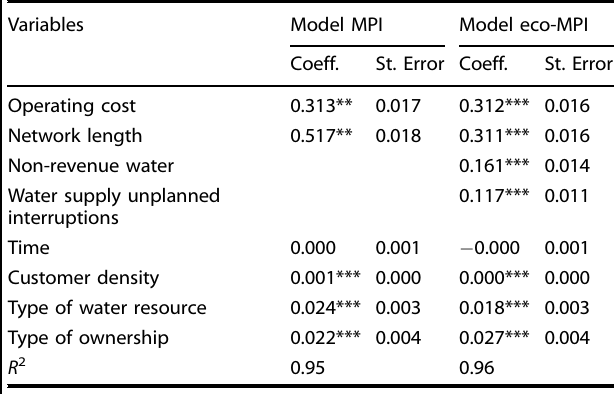
Table 1. Estimates of the StoNED frontier